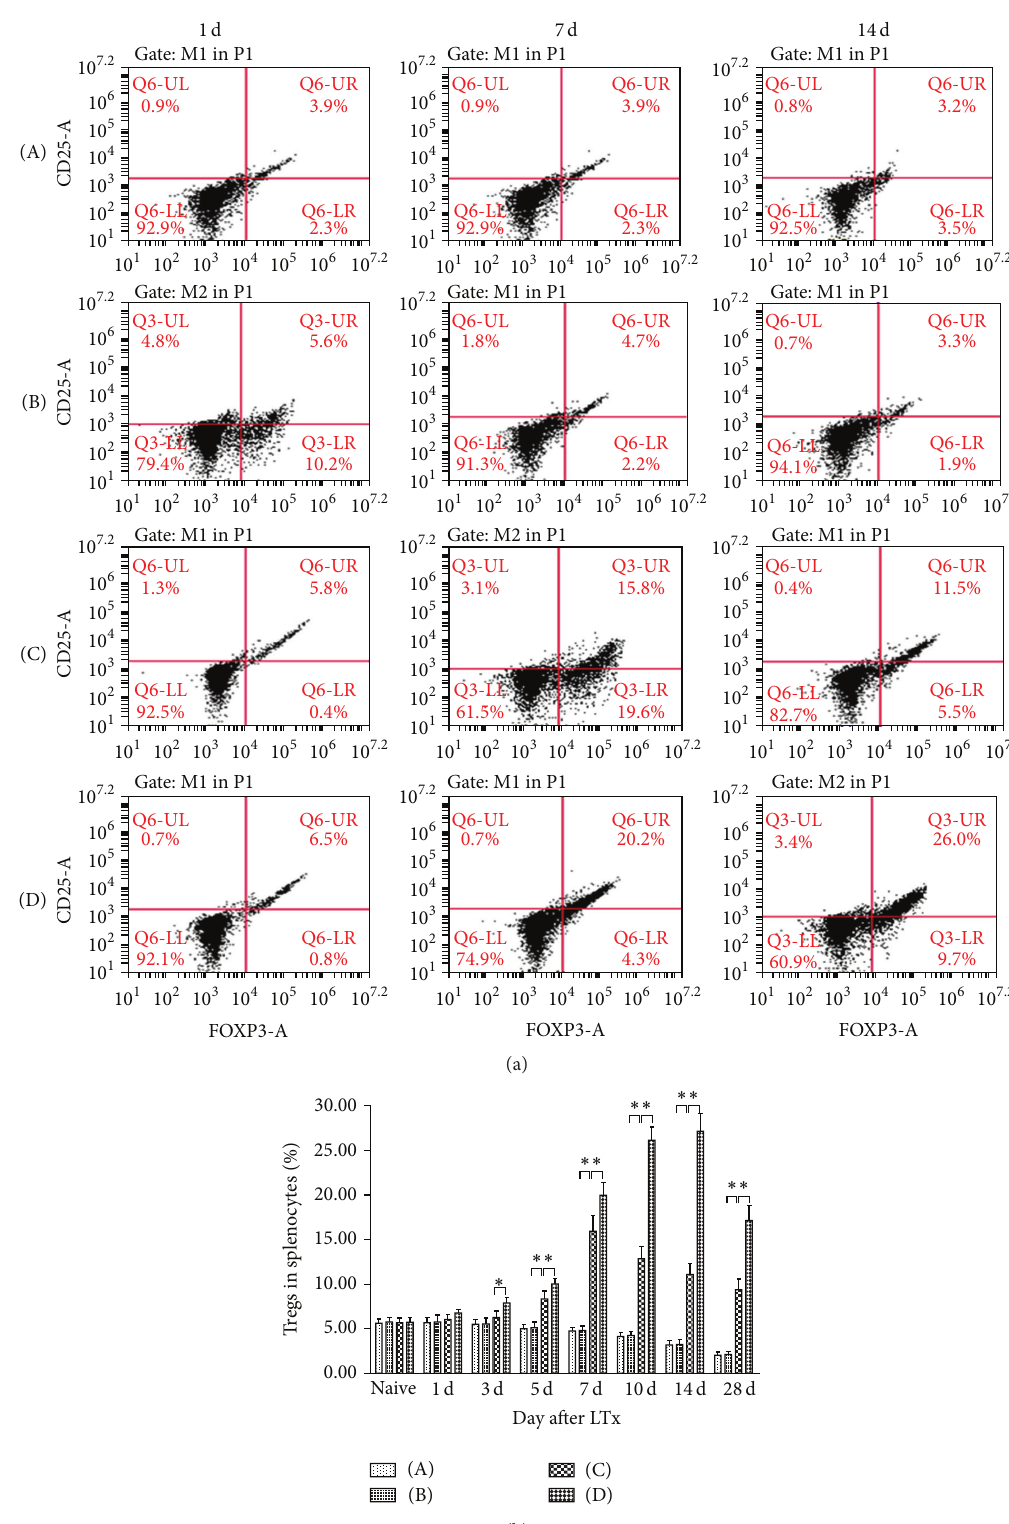
Figure 6: Proportion of Tregs in recipient splenocytes. (A) Normal saline group; (B) HO-1 group; (C) BMMSCs group; (D) HO-1/MSCs group. Percentages of CD4+CD25+Foxp3+ cells in recipient spleens were measured by flow cytometry. (a) Scatter plots on POD 1, 7, and